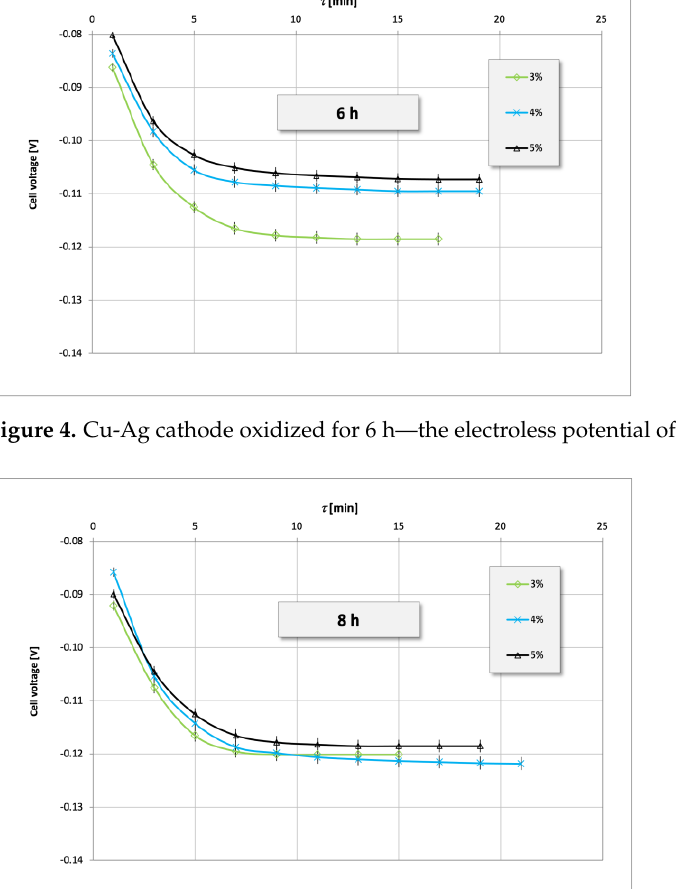
Figure 5. Cu-Ag cathode oxidized for 8 h — the electroless potential of cathode.